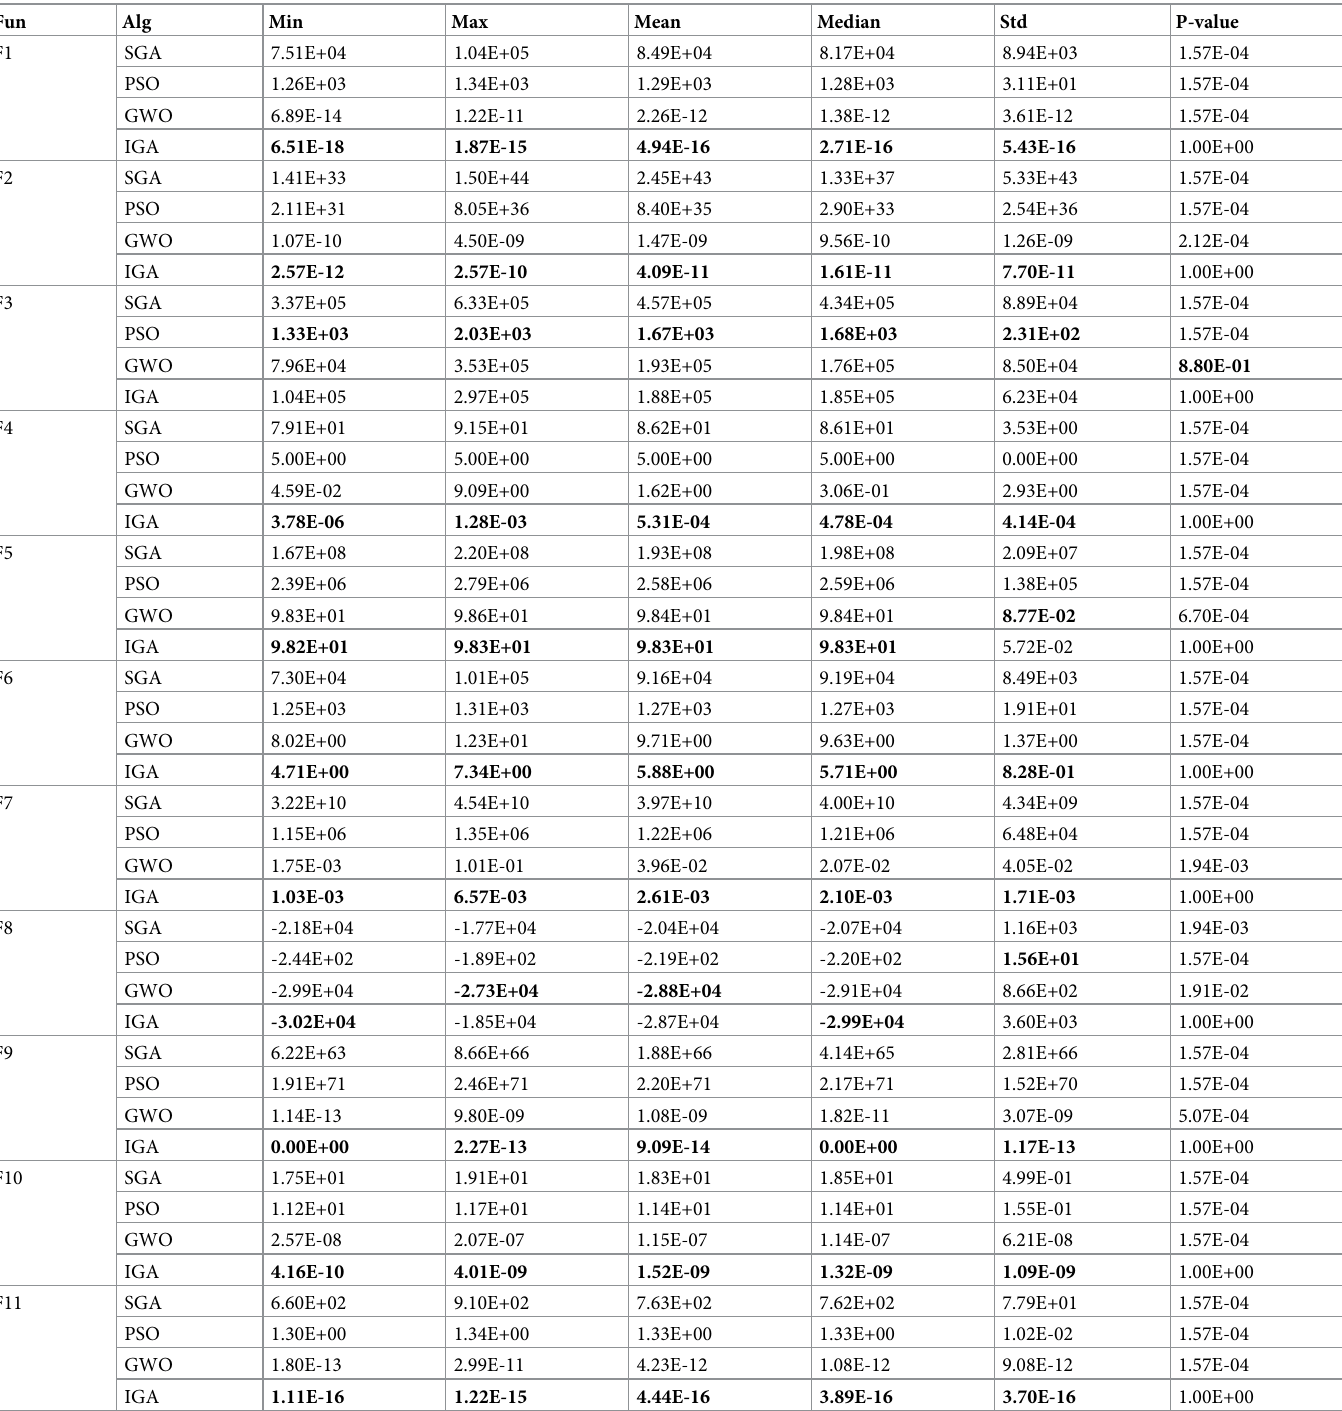
Table 7. Results of test functions (F1-F11) with 100